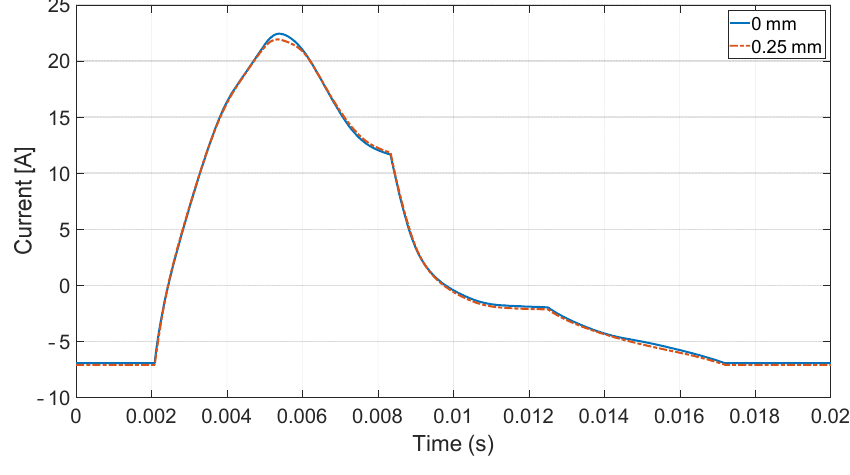
Figure 13. Phase current.